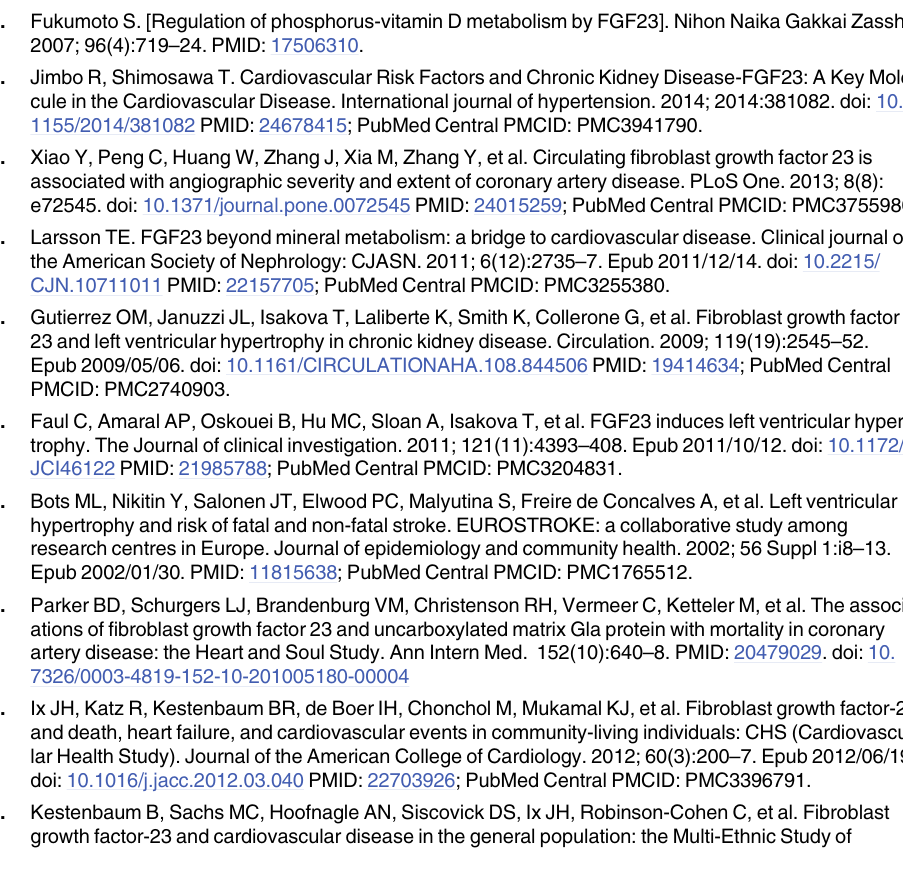
S2 Table. Multivariable linear regression for the associations between FGF23 concentra- tions and the best subset of FGF23 correlates, including phosphorus to protein ratio, mutu- ally adjusted for each other. S3 Table. Odd ratios (OR) and 95% Confidence Intervals (CI) for the associations between high FGF23 ( > = 90 RU/mL) and the best subset of its significant correlates, including phosphorus to protein ratio, mutually adjusted for each